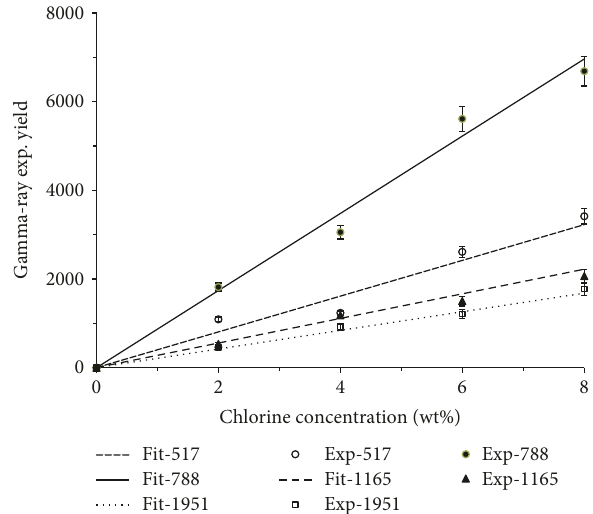
Figure 4: Integrated yield of 517, 788, 1165, and 1951keV prompt gamma-ray spectra of the CeBr detector from chlorine 3 contaminated water samples plotted as a function of chlorine concentration. The lines show normalized-calculated yields of the gamma rays obtained through Monte Carlo calculations.